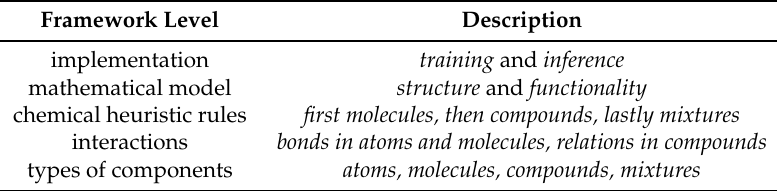
Table 1. Framework of artificial organic